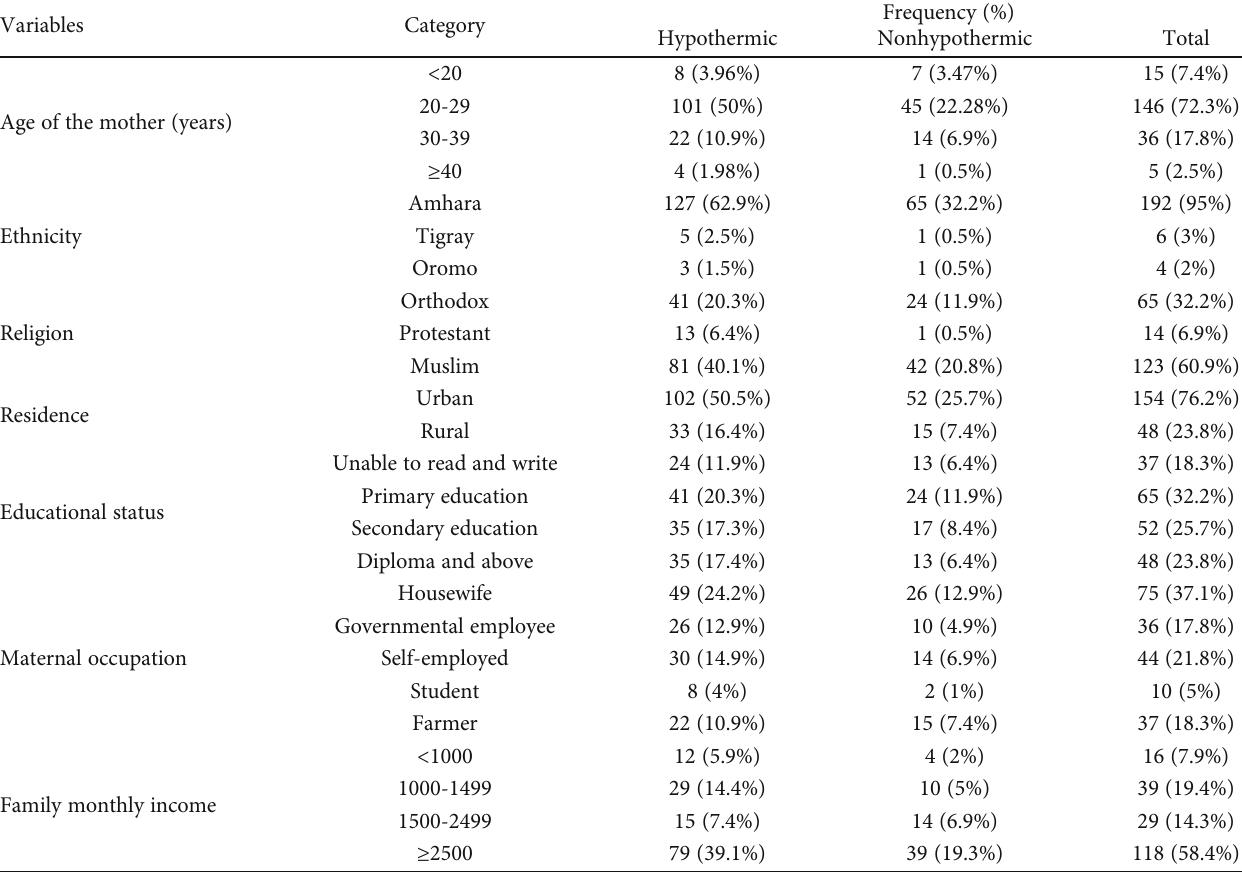
Table 1: Sociodemographic characteristics of mothers in Dessie Referral Hospital, Northeast Ethiopia, 2018 ( N = 202 ).